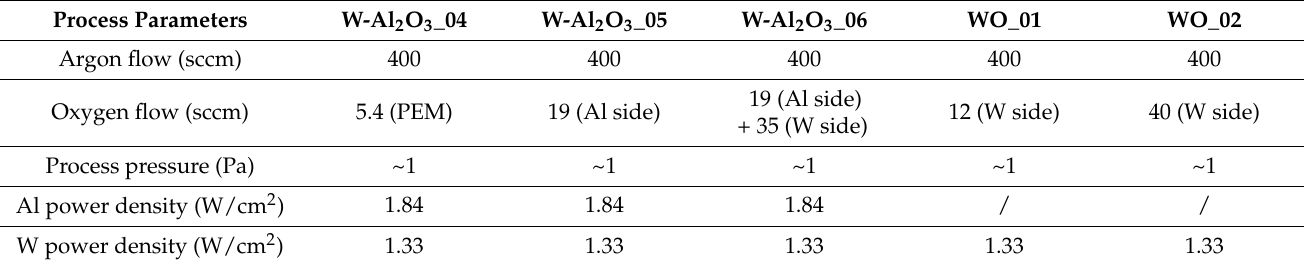
Table 3. Process parameters adopted to deposit cermet and WO samples on c-Si substrates.